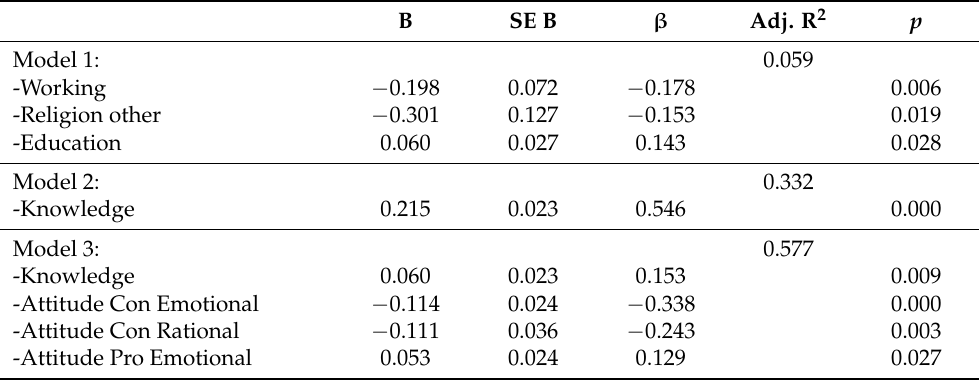
Table 5. Summary of the Stepwise Linear Regression for Intention to Vaccinate. B SE B β Adj. R 2